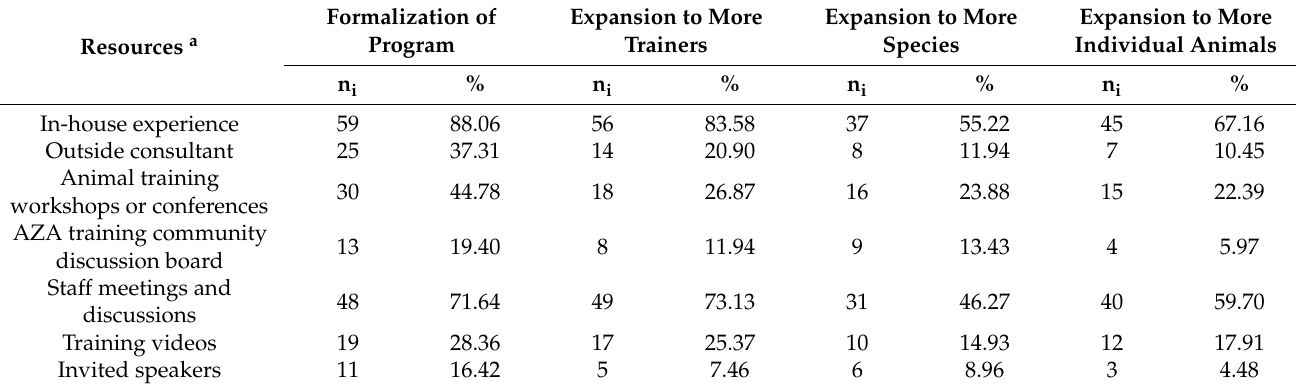
Table 1. Most helpful resources detected in establishing or advancing the training program with strepsirrhine